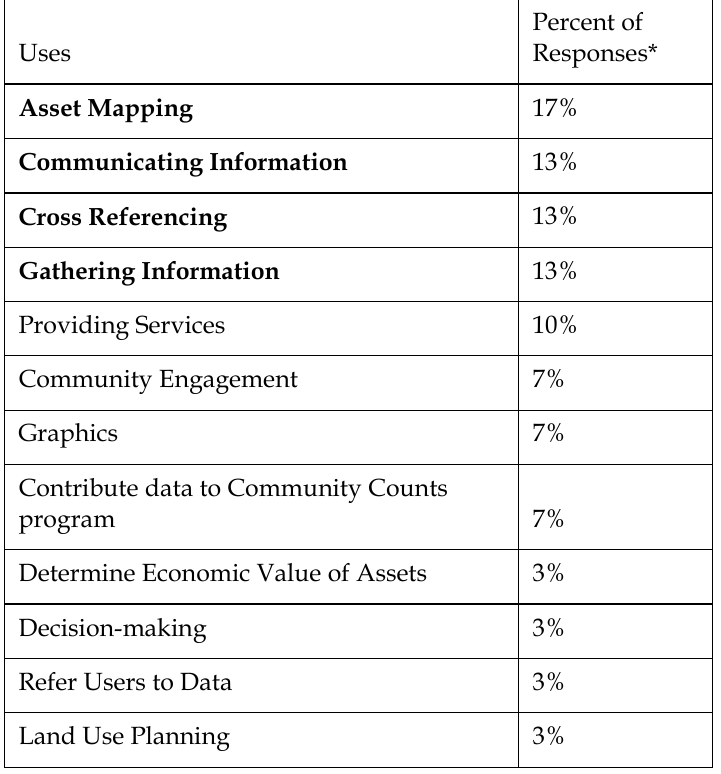
Table 1: Uses of Community